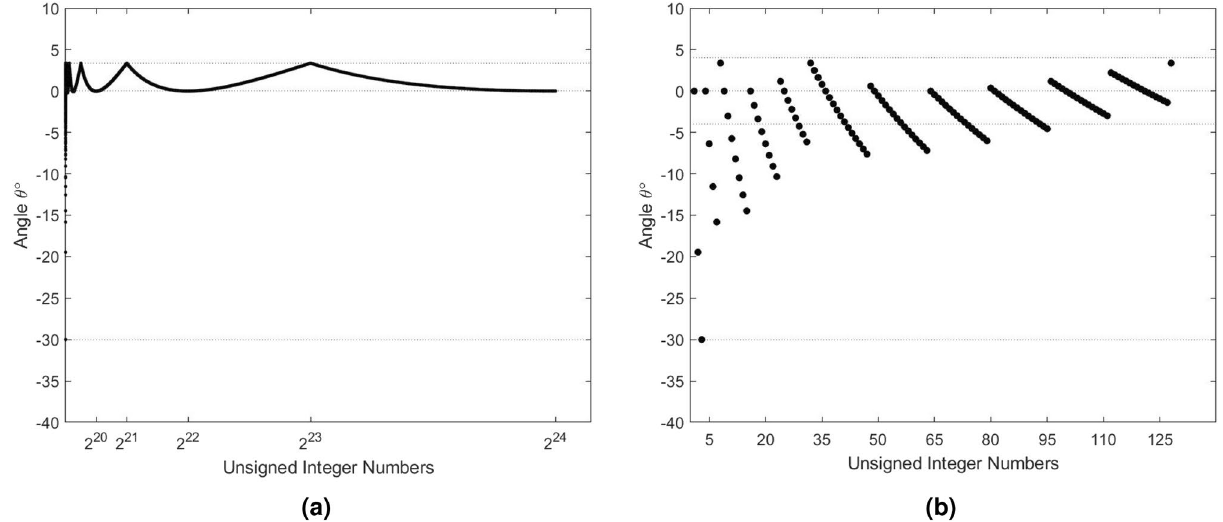
Figure 3. The range of θ (in degrees) as a function of x : ( a ) For all x up to 2 24 − 1 . ( b ) Zoomed plot for x up to